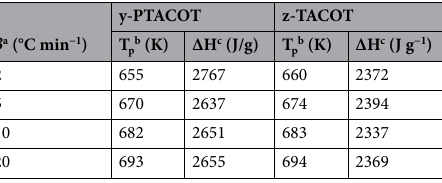
Table 1. Thermal decomposition parameters of y-PTACOT and z-TACOT. a β, heating rate; b T p , peak temperature (K); c ΔH, decomposition heat.